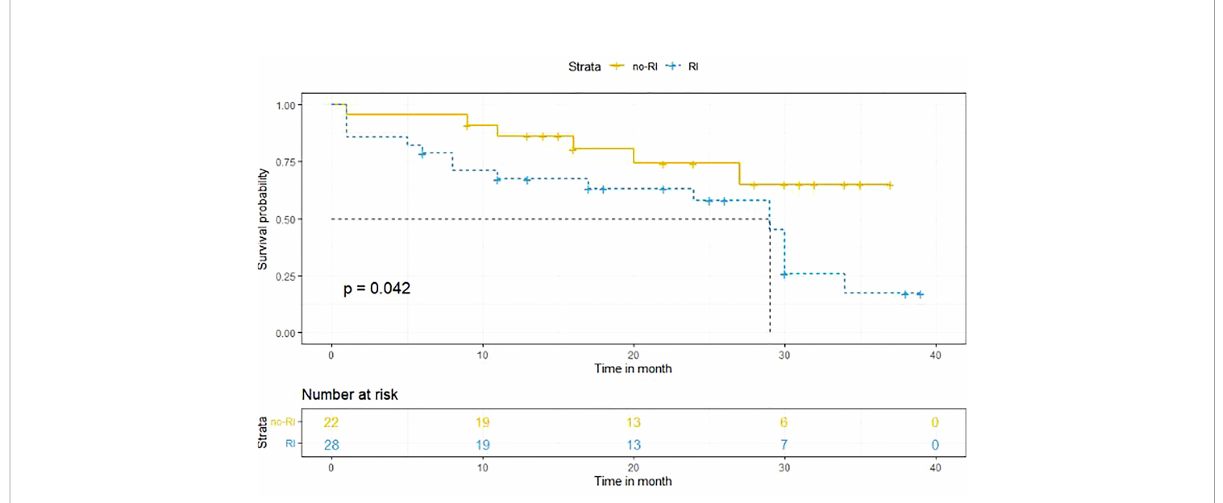
FIGURE 1 Survival analysis of the RI and no-RI groups. the median OS in the RI group was shorter than that in the no-RI group. The median OS in the RI group was 29 months, while the median OS in the no-RI group was > 40 months ( p =